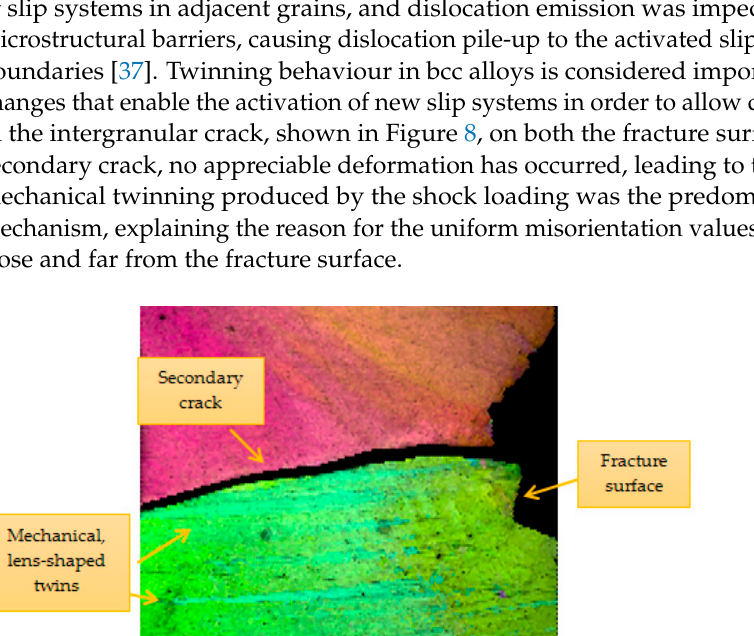
Figure 7. Phase and KAM maps of the fracture surface profile of Charpy impact tested CuZn42 alloy samples: ( a ) phase map, ( b ) KAM map in the as-drawn condition, and ( c ) KAM map in the heat treated condition.